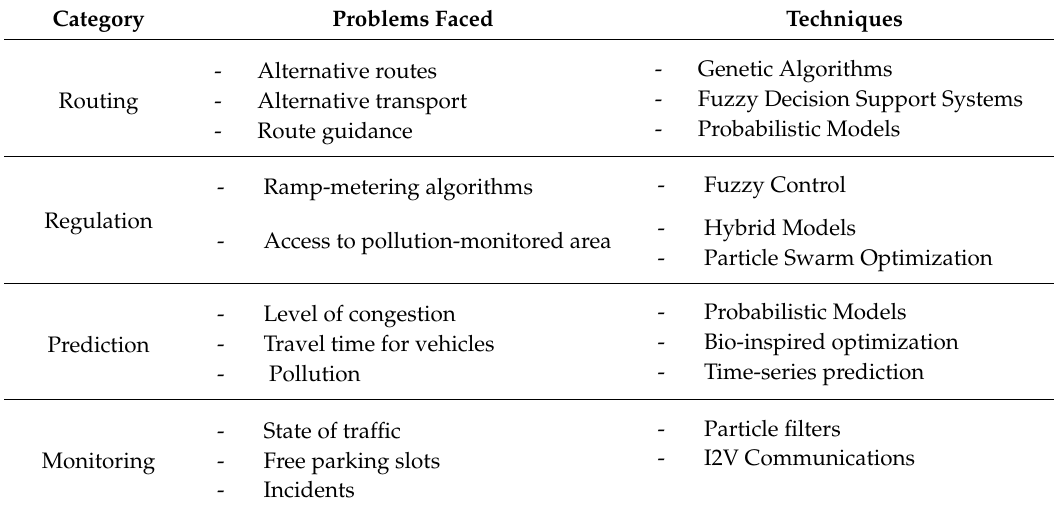
Table 1. Different Problematic being faced by